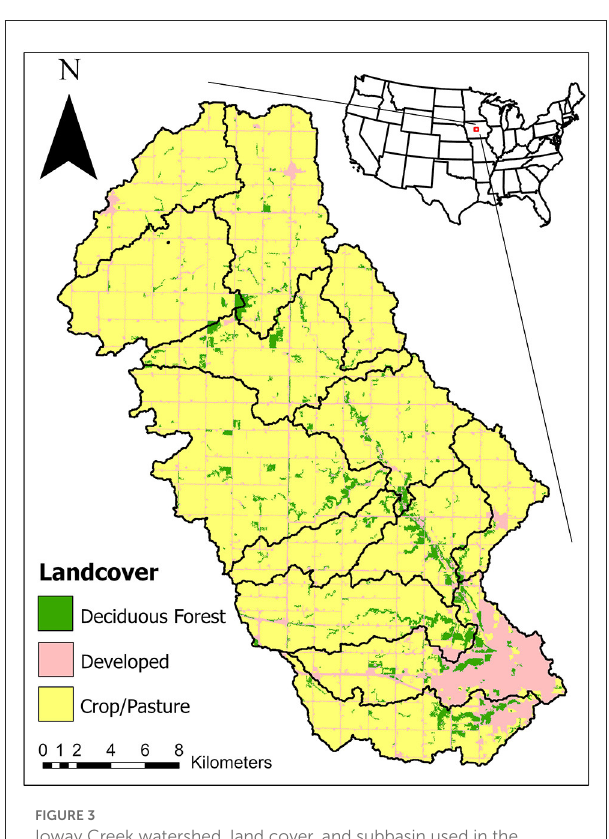
FIGURE3 Ioway Creek watershed, land cover, and subbasin used in the hydrology